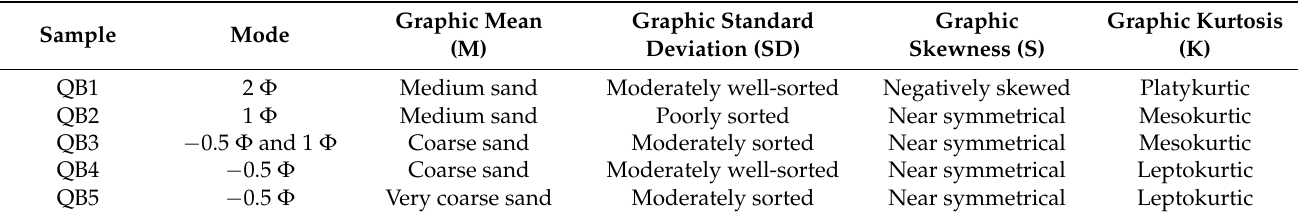
Table 2. Summary on analysis of frequency curves of the five sediment samples in Persiaran Bayan Indah (the Queensbay Mall area), representing the sediments of anthropogenic coastal landform or reclamation coastline.